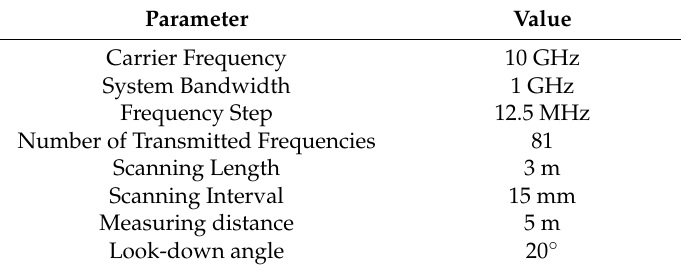
Figure 13. Photos of the PolSAR system in the anechoic chamber. ( a ) Antenna layout; and ( b ) the whole scene. Table 3. System parameters.